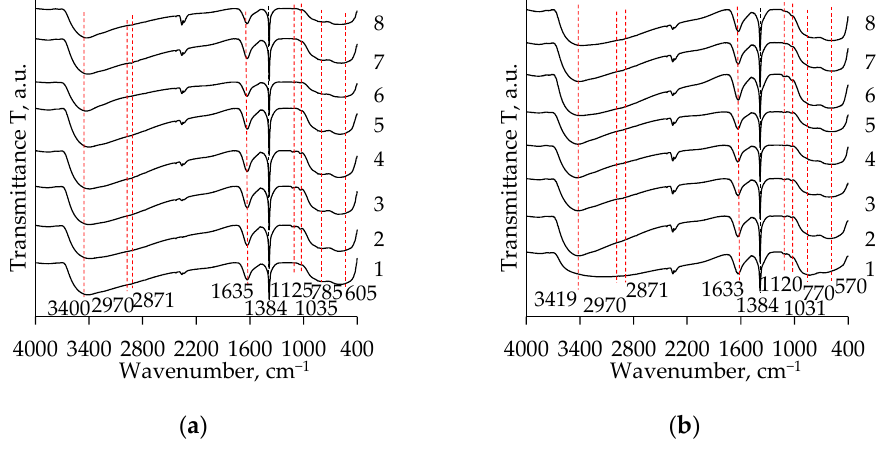
Figure 1. FT-IR spectra of the TiO 2 aerogels after subcritical drying (800 mbar, 70 °C, 8 h) without aging (1–4) and after 72 h of aging (5–8) depending on the precursor type (TIP ( a ), TBOT ( b )) and the solvent used for an additional solvent exchange (1, 5—without exchange; 2, 6—CH; 3, 7—nH; 4, 8—DE).